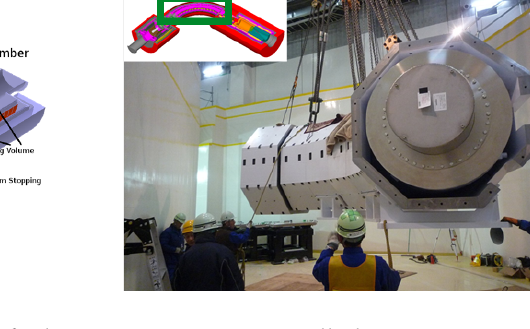
Figure 8: Installed muon transport